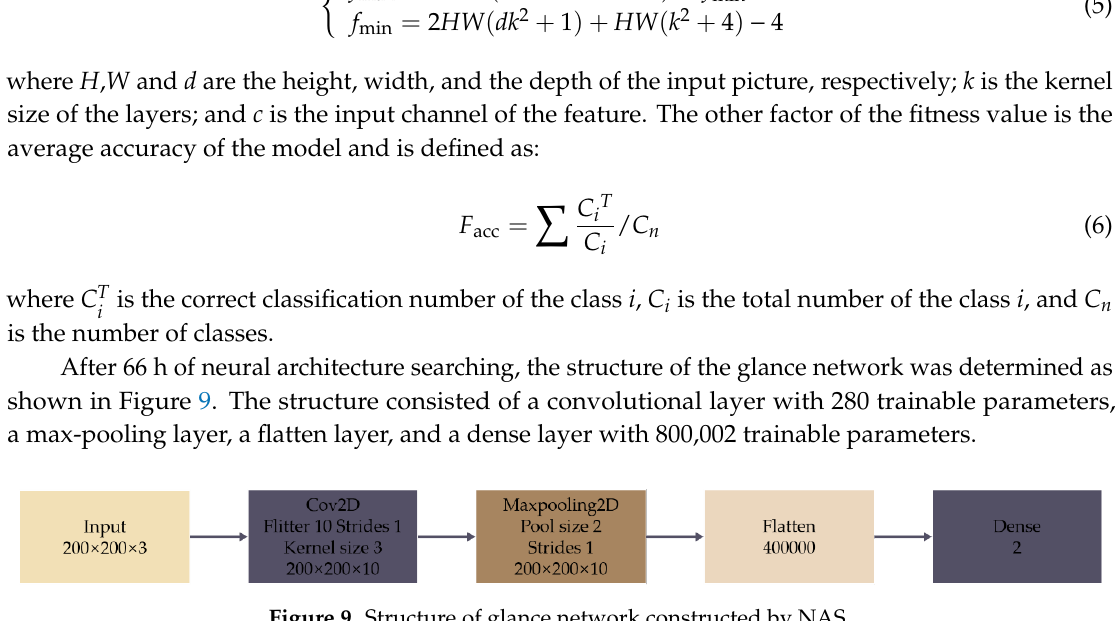
Table 2. Comparison results for different numbers of features.